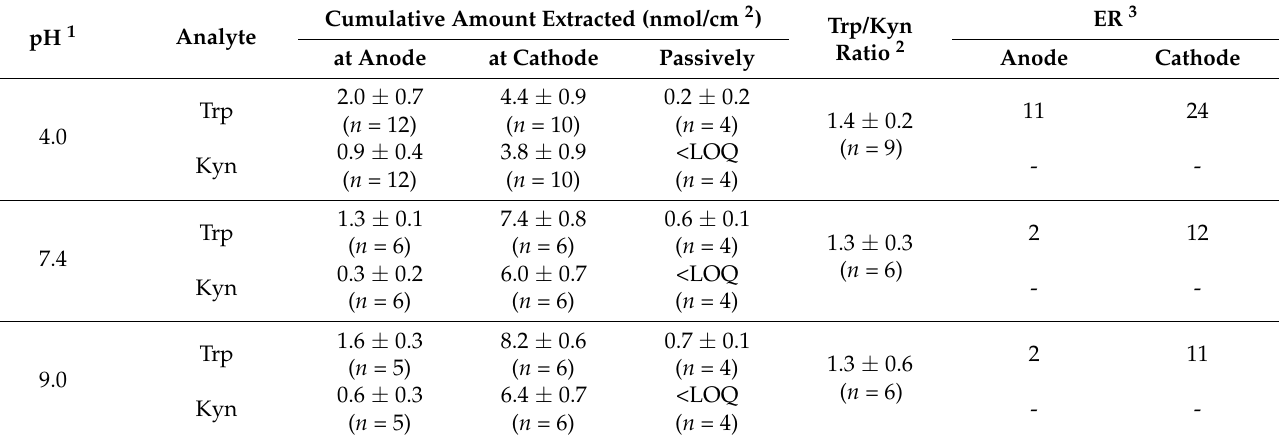
Table 2. Cumulative amounts of Trp and Kyn extracted by reverse iontophoresis and passive diffusion after 6 h and at three different receiver solution pH values. The data presented are mean ± SEM. Cumulative Amount Extracted (nmol/cm 2 pH 1 Analyte